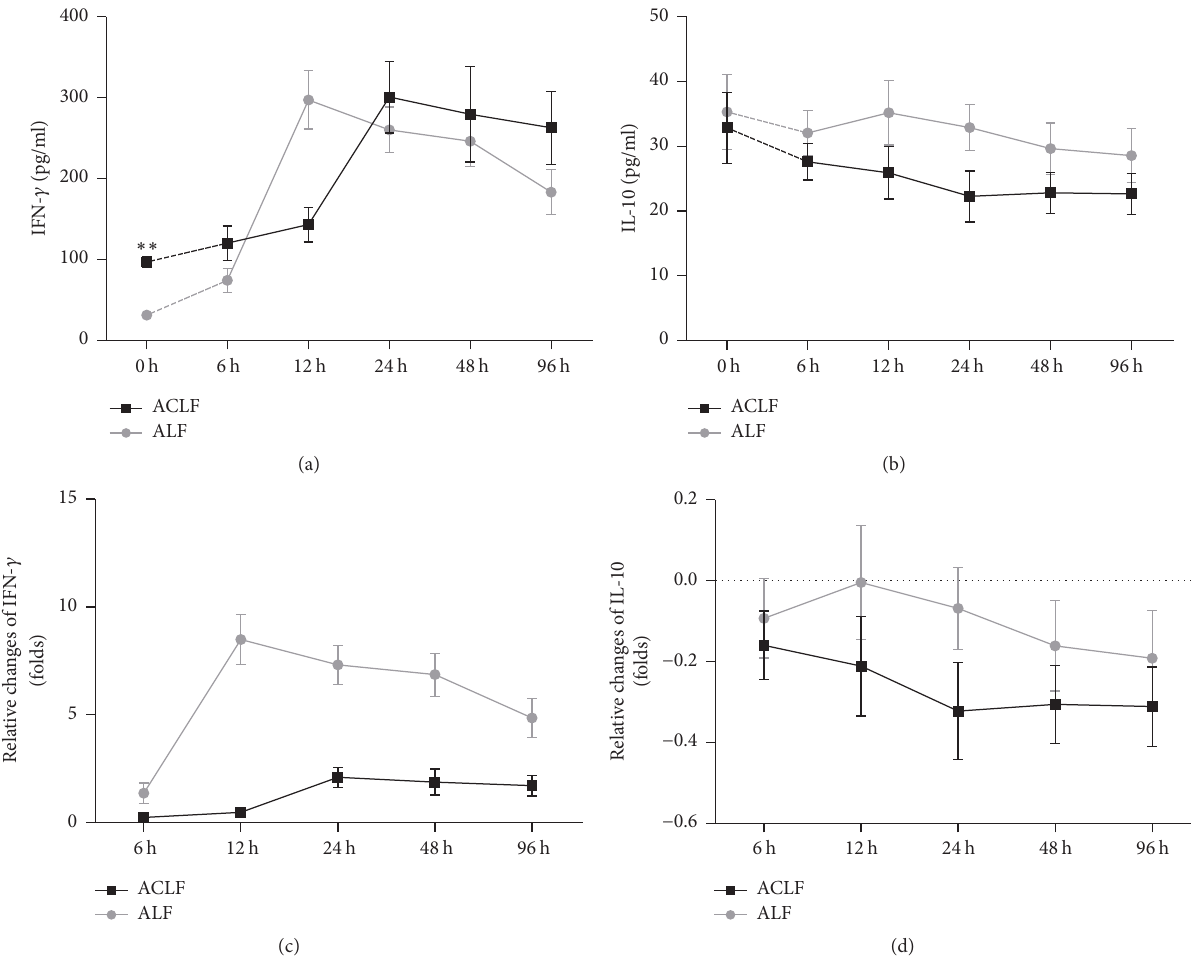
Figure 7: Serum levels of IFN- 𝛾 and IL-10. (a, b) Changes of IFN- 𝛾 and IL-10 level in serum in ACLF group and ALF group. (b) IFN- 𝛾 and IL-10 levels were normalized by “0h” subgroup, respectively; ∗∗ 𝑝 < 0.01 . (IFN- 𝛾 : interferon- 𝛾 ; IL-10: